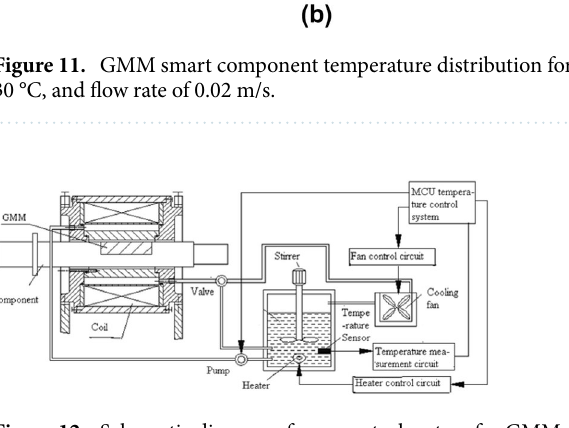
Figure 12. Schematic diagram of new control system for GMM smart